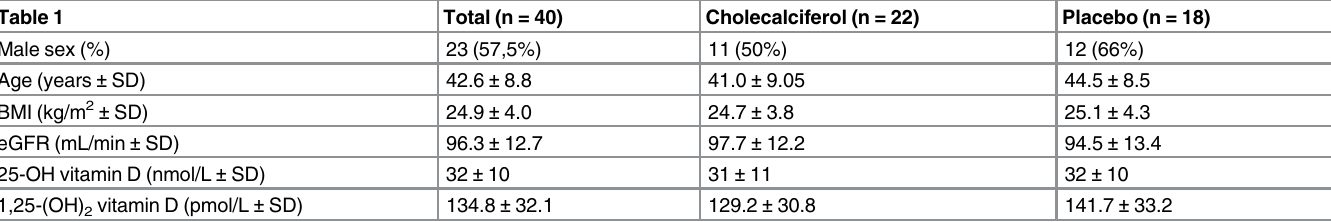
Table 1. Demographic